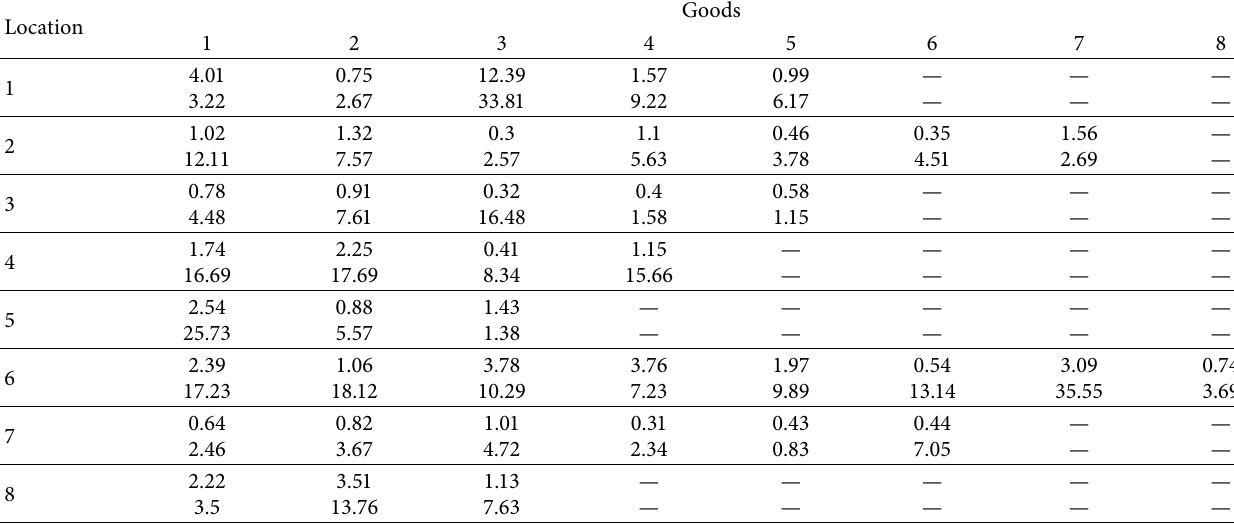
Table 1: The parameters of all goods.